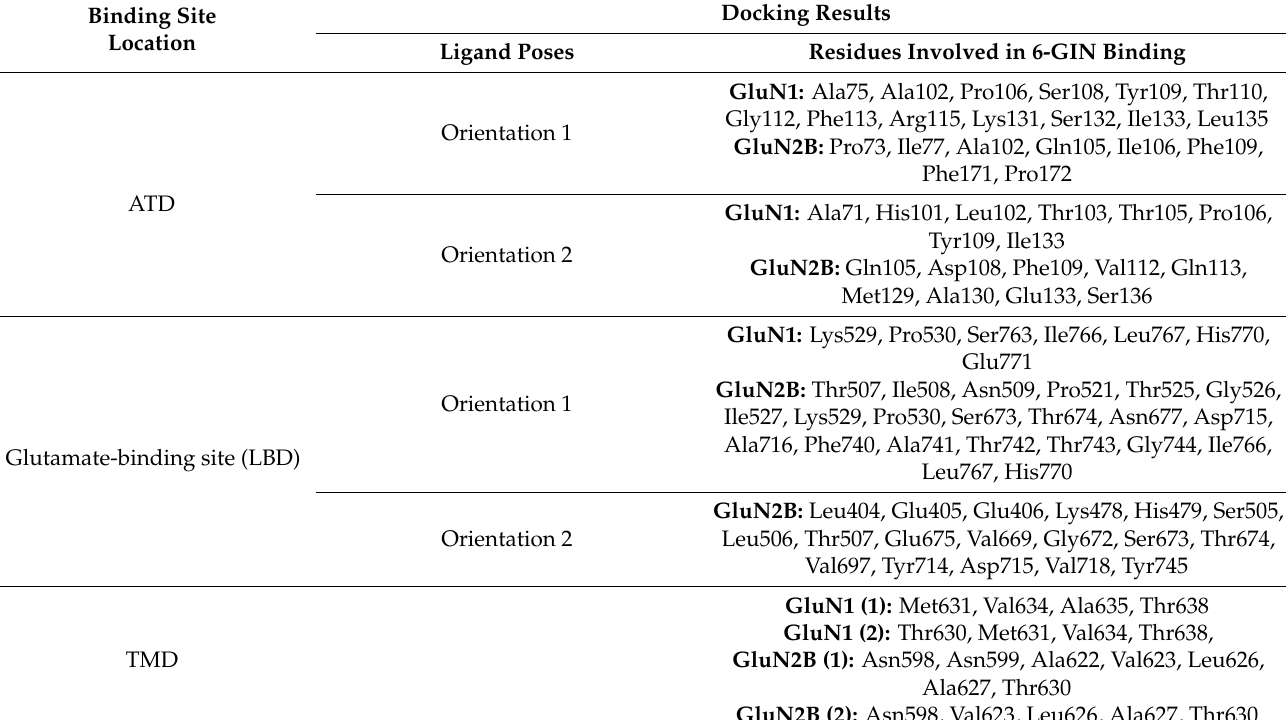
Table 1. Molecular interactions of 6-GIN with GluN1/GluN2B NMDA